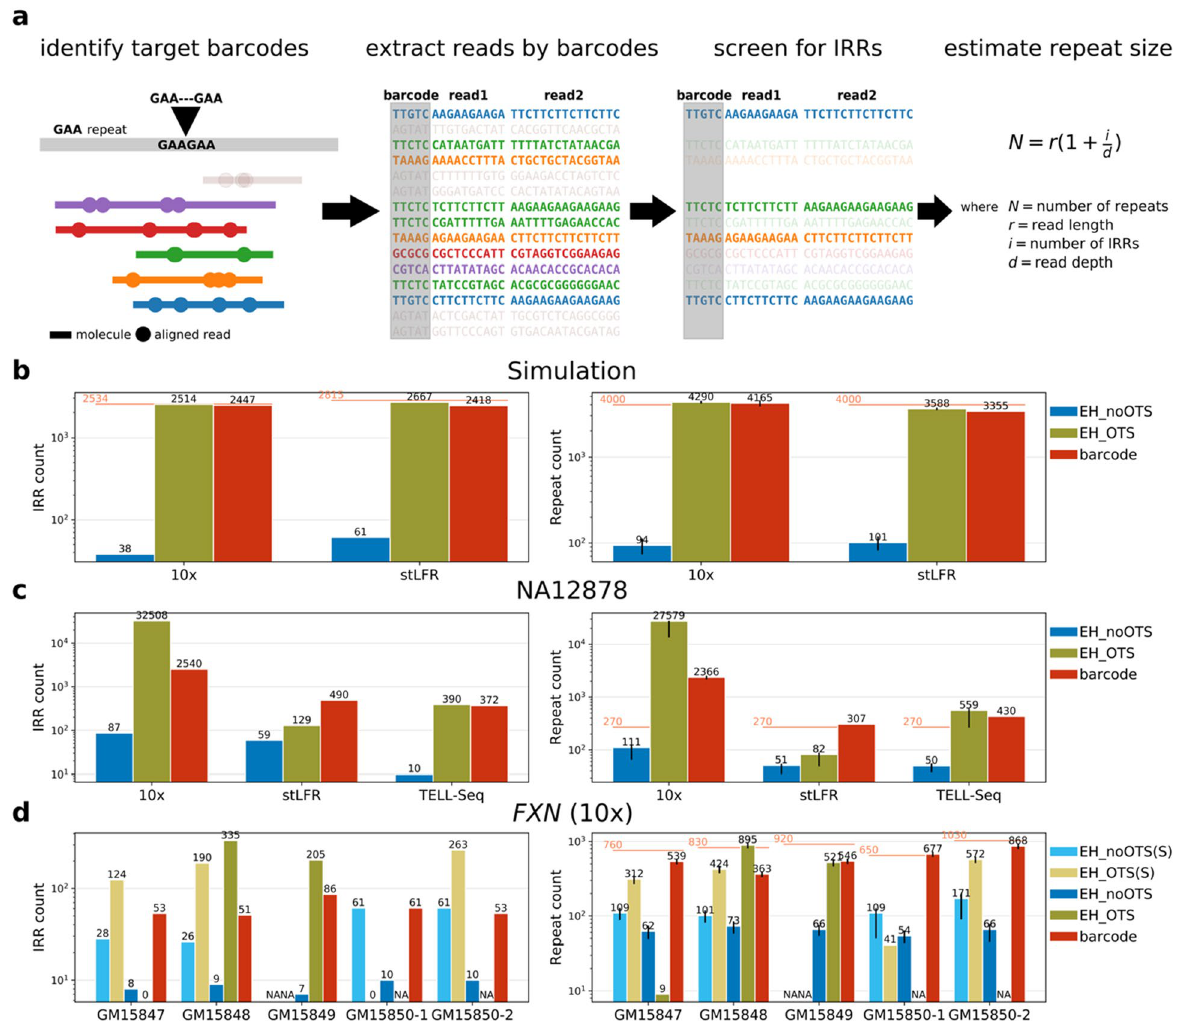
Figure 1. IRR extraction using barcodes in BLRS. ( a ) Steps in using barcodes for IRR extraction and STR size estimation. ( b–d ) IRR counts (left) and repeat count estimates (right) of the target loci within the three groups of datasets: ( b ) heterozygous ATTCT expansion in ATXN10 10 × and stLFR simulations; ( c ) homozygous larger-than-reference CCAT polymorphism in NA12878 from 10x, stLFR, and TELL-Seq BLRS platforms; and ( d ) FXN GAA expansions in 10 × data of four Coriell cell lines. The methods in comparison were EH without OTS (EH_noOTS, blue), EH with OTS (EH_OTS, olive), and barcode-based IRR extraction (barcode, red). For the FXN samples, EH results (with or without OTS) from standard Illumina data (EH_OTS(S), light blue and EH_noOTS(S), light olive) were also included. Only results of the expanded alleles in the samples were shown (therefore two separate tallies for the homozygous FXN GM15850 sample). “Expected” or “ground truth” IRR counts (for the simulations) and repeat counts were plotted as orange horizontal bars together with the exact numbers. Exact IRR or repeat counts were shown on top of each bar. Confidence intervals of the estimates reported by EH were shown as error bars. For the custom barcode-based method, the error bars reported for 10 × data corresponded to the range of estimates calculated independently using each of the two read lengths (see the Methods section). “NA” indicates that results were unavailable for certain samples because of a segmentation fault in EH